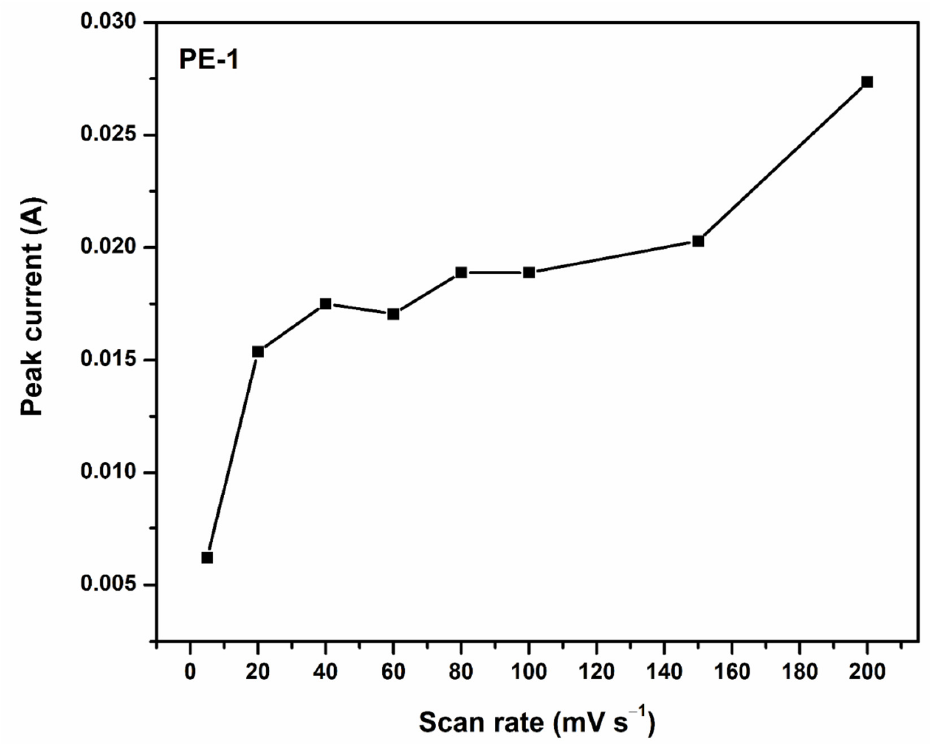
Figure 5. Anodic peak current values of PVA-20 wt% TEOS (PE-1) at various scan rates (5 to 200 mV s − 1